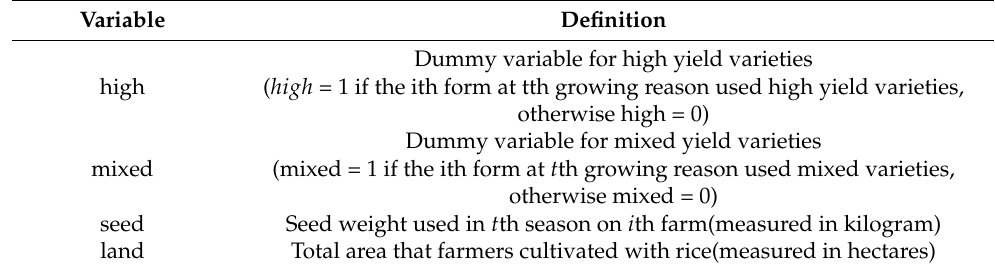
Table 8. Variables and their definitions.